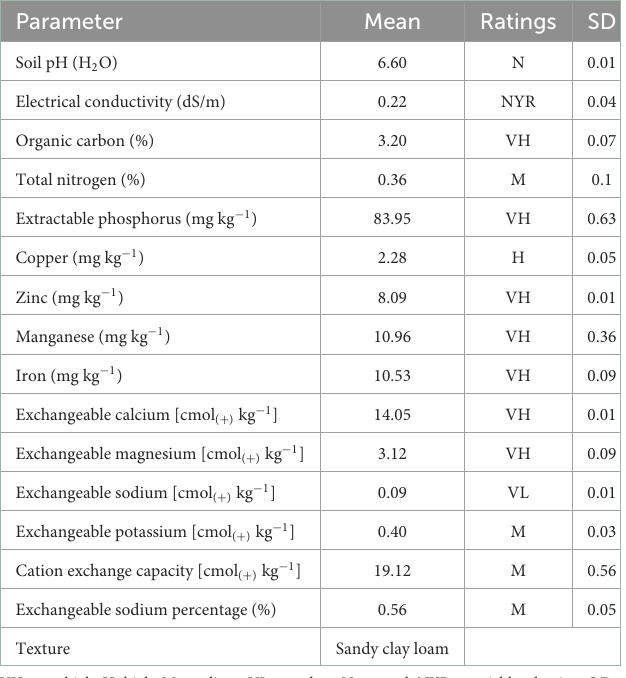
TABLE 1 Physicochemical parameters of an experimental